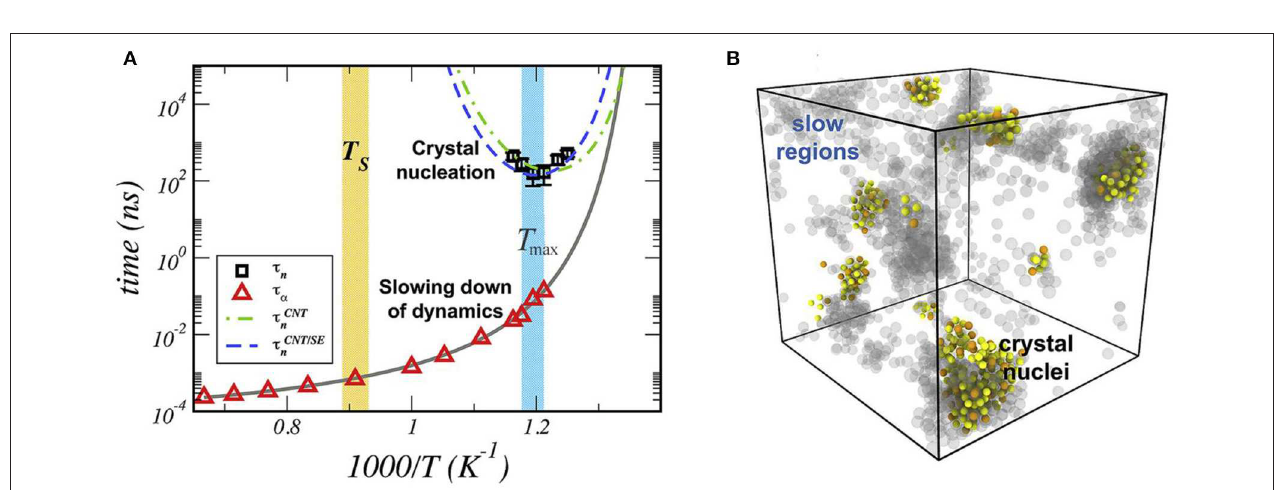
FIGURE 4 | (A) Temperature dependence of the nucleation time (squares), τ n , and relaxation time (triangles), τ α , of Cu atoms. The solid line is a fit of relaxation data by the Vogel-Fulcher-Tammann equation. The dash-dotted and dashed lines show the CNT predictions of the nucleation time. The shaded regions mark the onset temperature, T S, and the temperature T max (with their uncertainty). (B) colored particles = crystal nuclei; gray particles = slow regions of dynamical heterogeneities for selected configurations at T = 837K, close to T max , and t = 160 ns (adapted from Puosi and Pasturel [22] with permission from